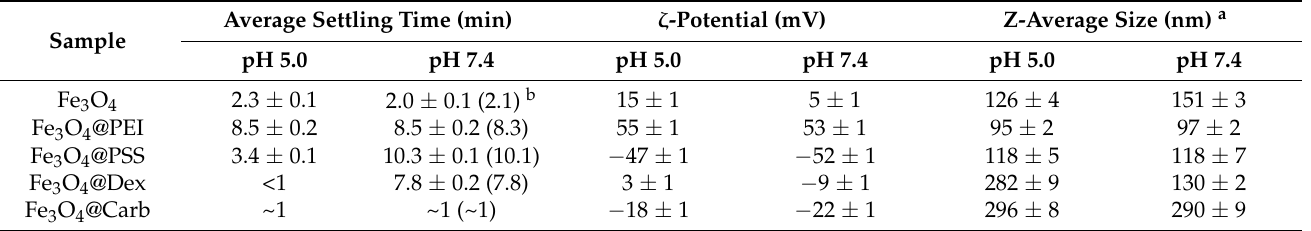
Table 4. Colloidal stability, zeta-potential, and hydrodynamic size of aqueous suspensions with